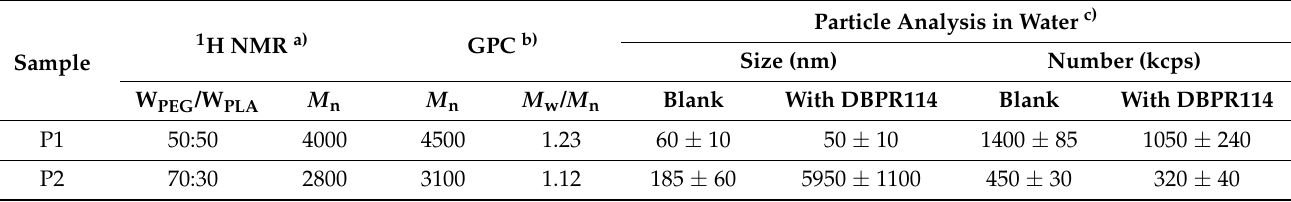
Table 1. Compositional and molecular characteristics of the designed PEG–PLA copolymers.